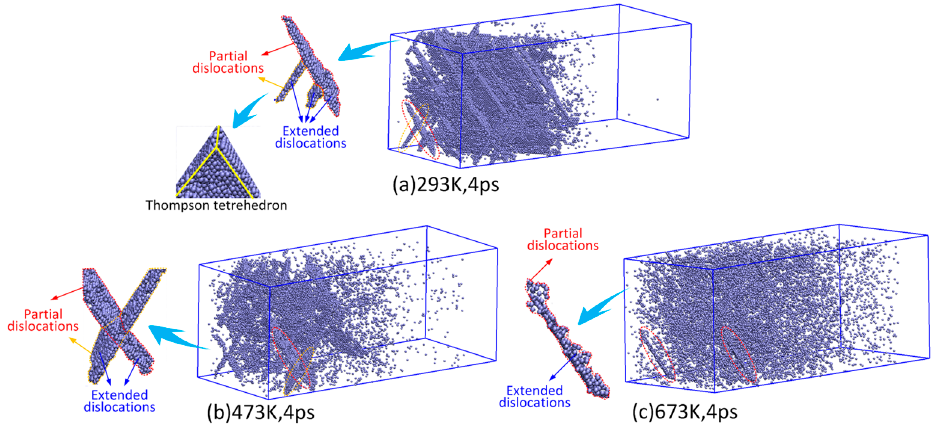
Figure 8. Evolution of the dislocation atoms induced by the laser shock wave at 4 ps under different temperatures; ( a ) 293 K; ( b ) 473 K; and ( c ) 673 K.